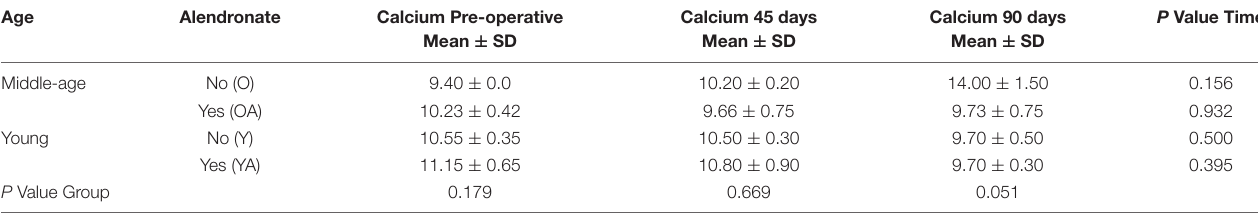
TABLE 1 | Serum levels of calcium at different times.